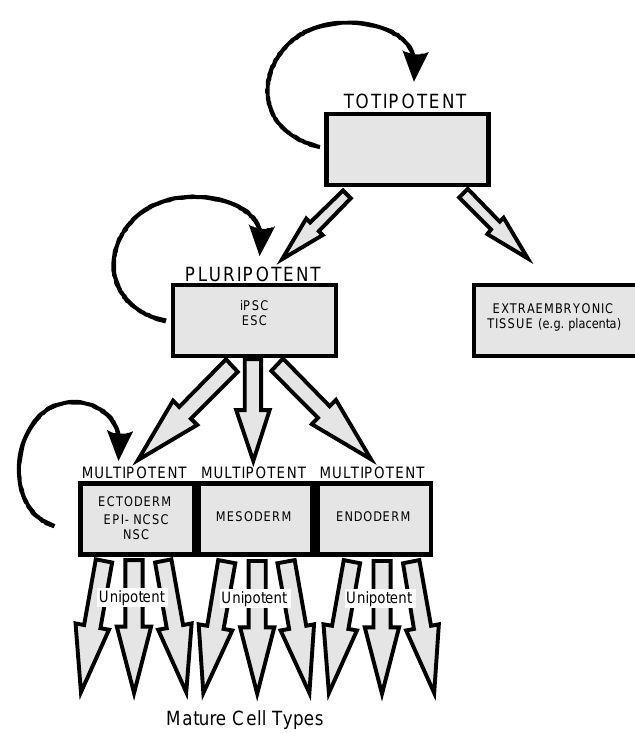
Figure 2. Stem cell differentiation